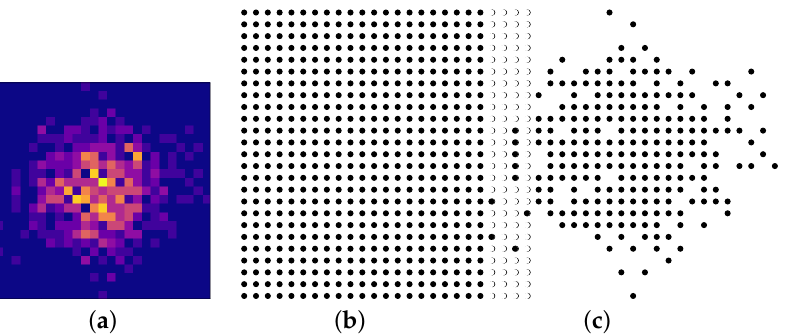
Figure A1. SAR score map representation with a grid of nodes. ( a ) An example of a score map with 25 × 25 tiles. Colours represent scores ranging from purple (low scores) to yellow (high scores). ( b ) Grid representation of the score map. ( c ) Filtered grid without nodes of score